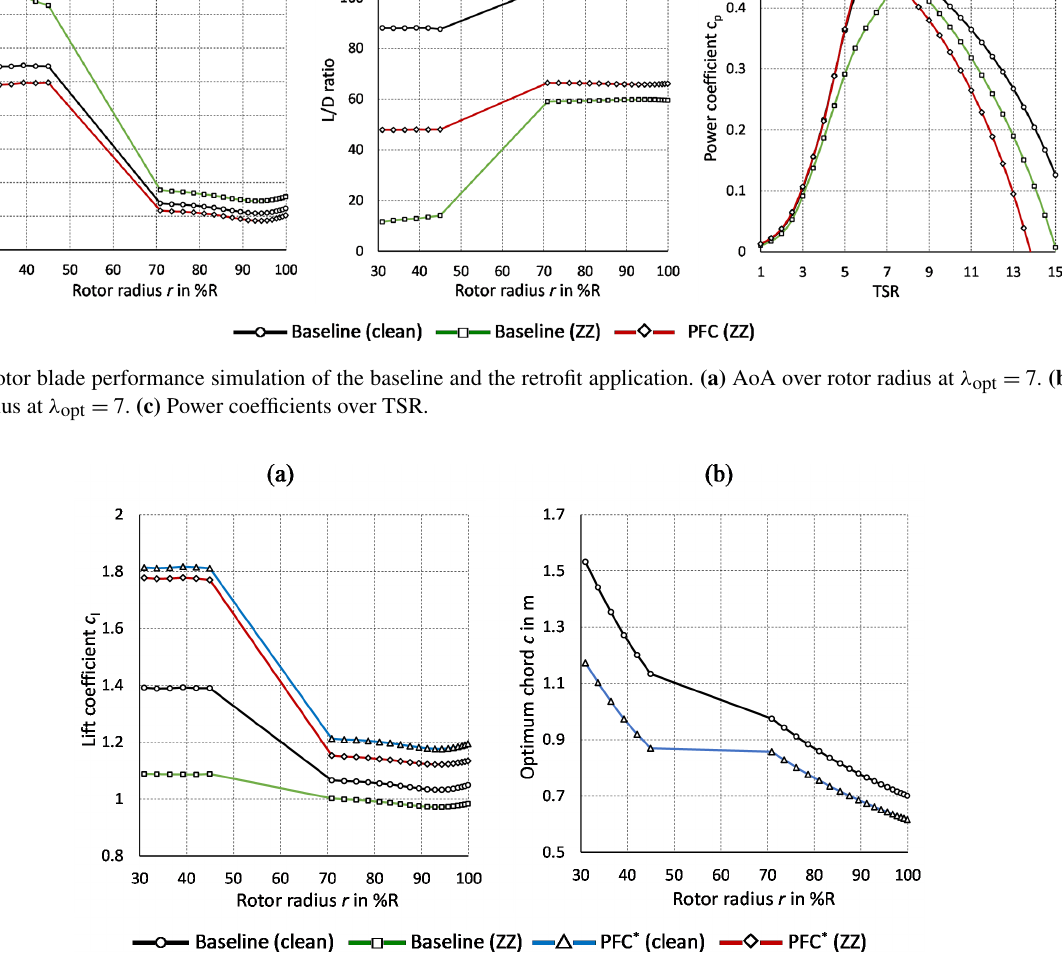
Figure 17. Blade geometry of the baseline and the new design application at λ opt = 7. (a) Lift coefficients over rotor radius. (b) Optimum chord length over rotor